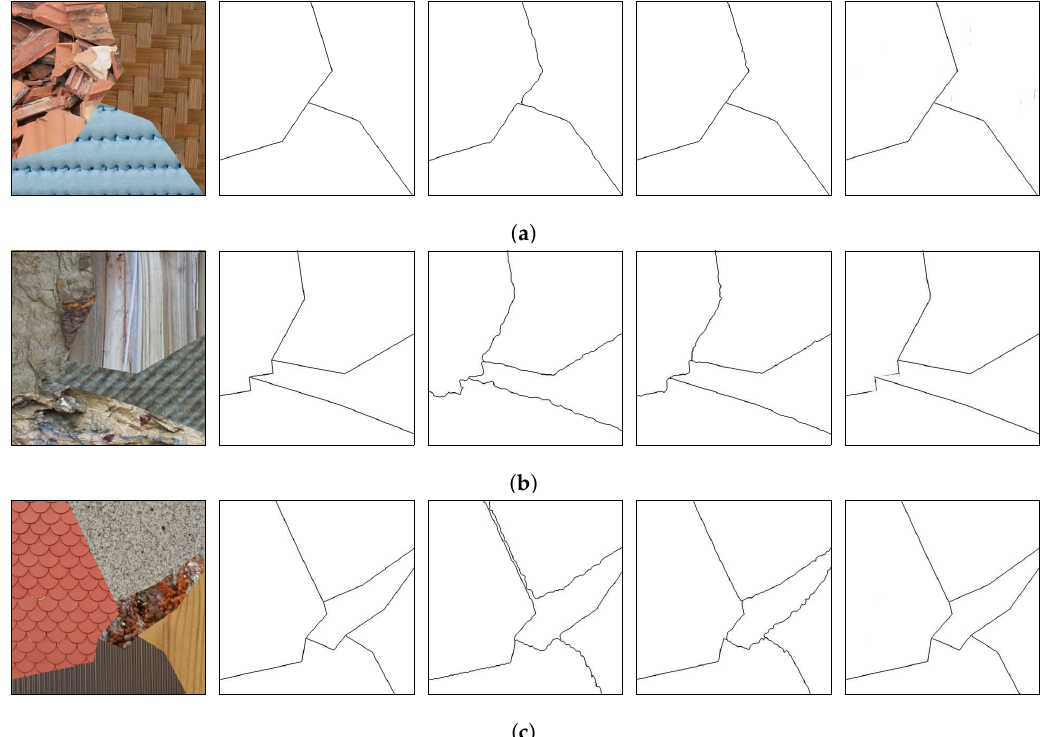
Figure 14. Comparison on the Prague Texture Dataset Generator and Benchmark [70]. From the first to the fifth column, respectively: original images; ground truths; edges produced by the network in [67]; edges produced by the network in [69]; edges produced in the presented method. Letters ( a – c ) present different benchmark textures mosaics and are used for referencing the images in the